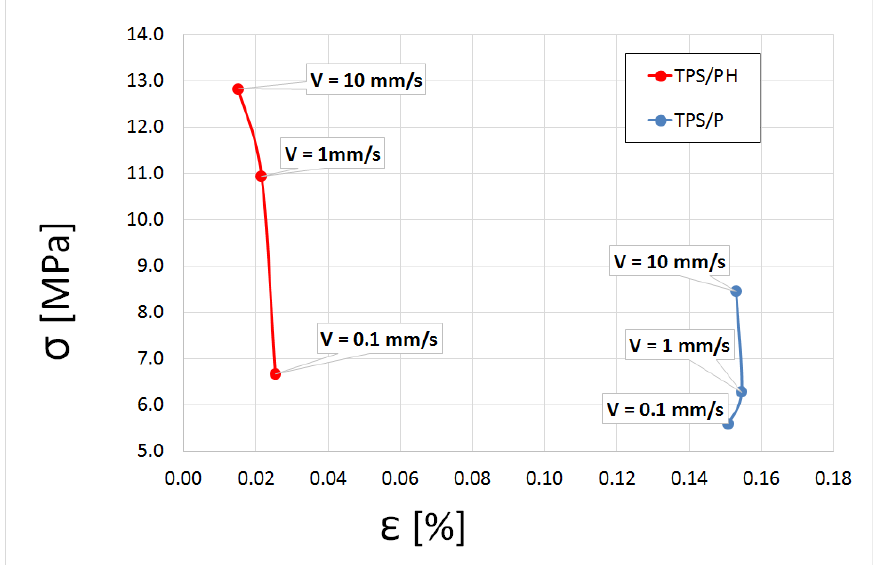
Figure 8. The relationship between failure stress, σ (MPa), and failure strain, ε (%), at different deformation velocities.